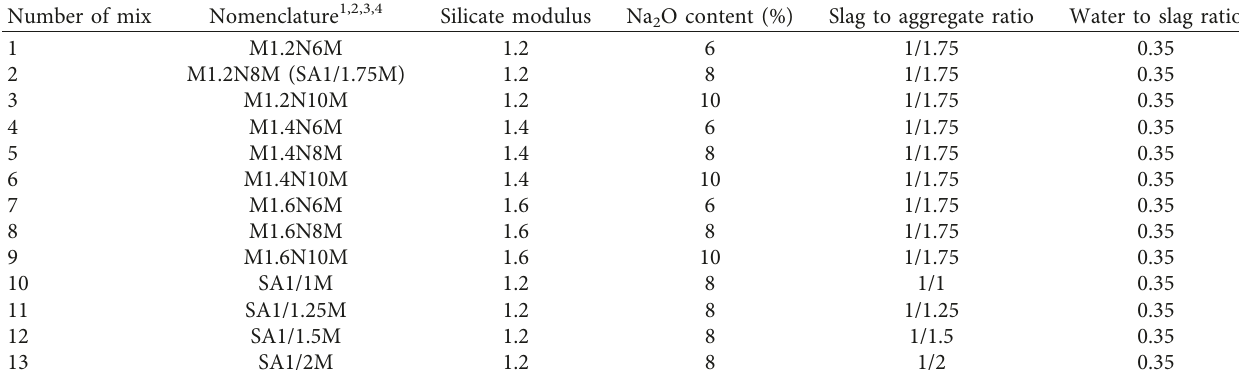
Table 2: The mixing proportions used in this study.